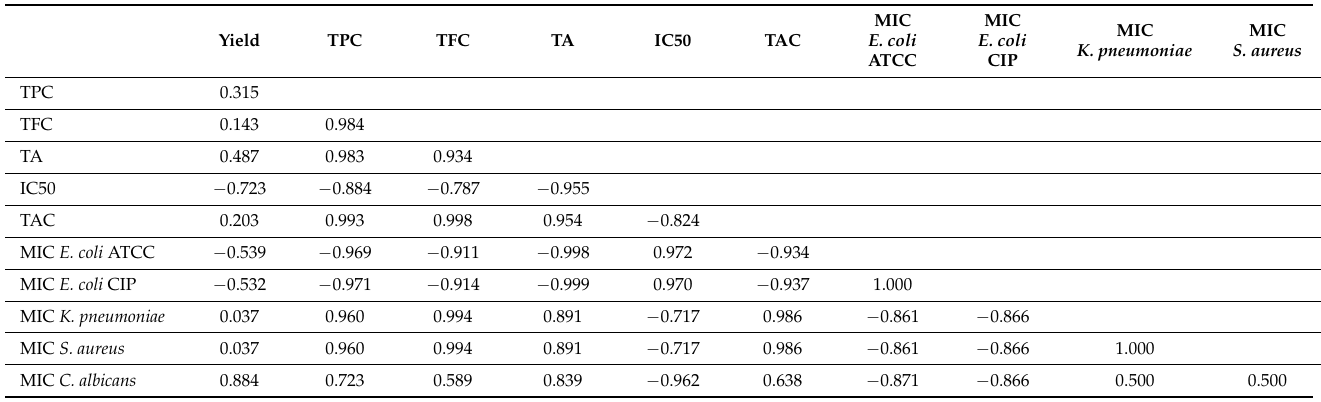
Table 3. Correlation between studied parameters of P. rhoeas